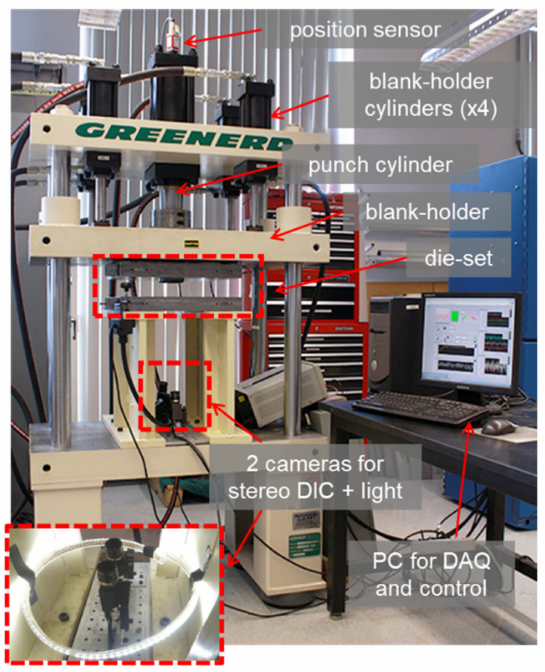
Figure 12. Instrumented hydraulic press used for Marciniak FLC experiments with its major components